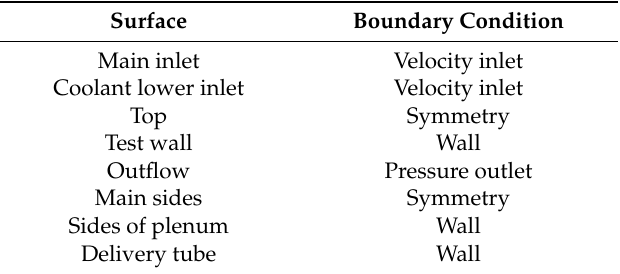
Table 1. The boundary conditions for the computational domain [28].